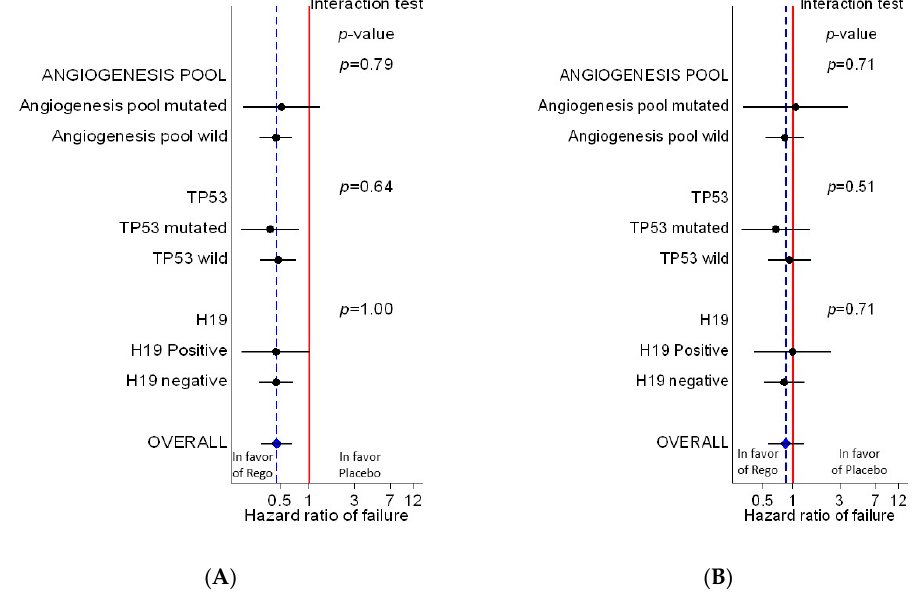
Figure 2. Forest plot ( A ) (for progression-free survival) and ( B ) (for overall survival) showing the heterogeneity of treatment effect according to the status of each